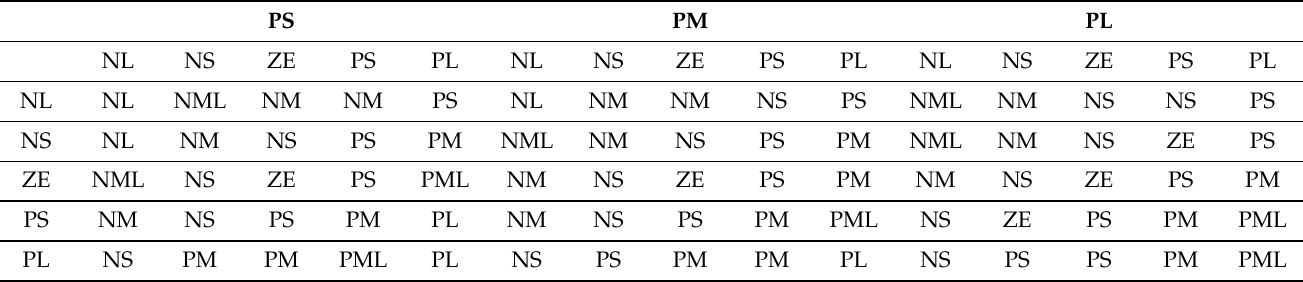
Table 1. rules for input and output